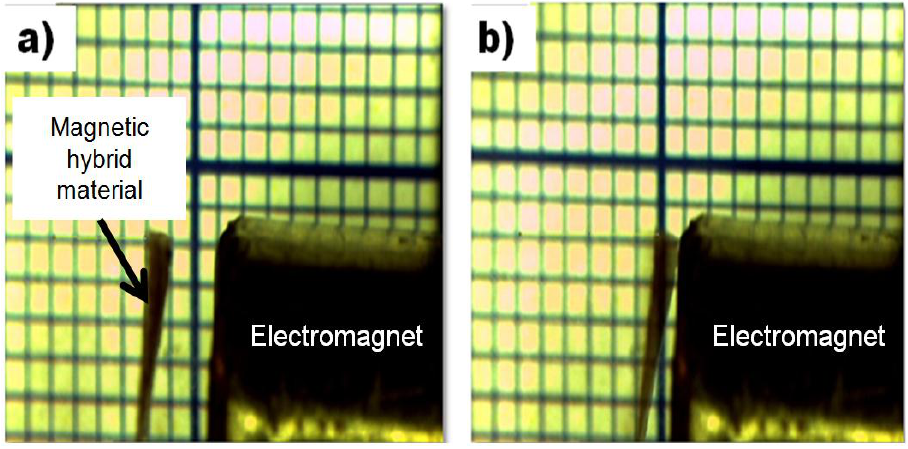
Figure 9. Displacement of the composite material when an external magnetic field is applied (top-view). ( a ) Initial position. ( b ) Final